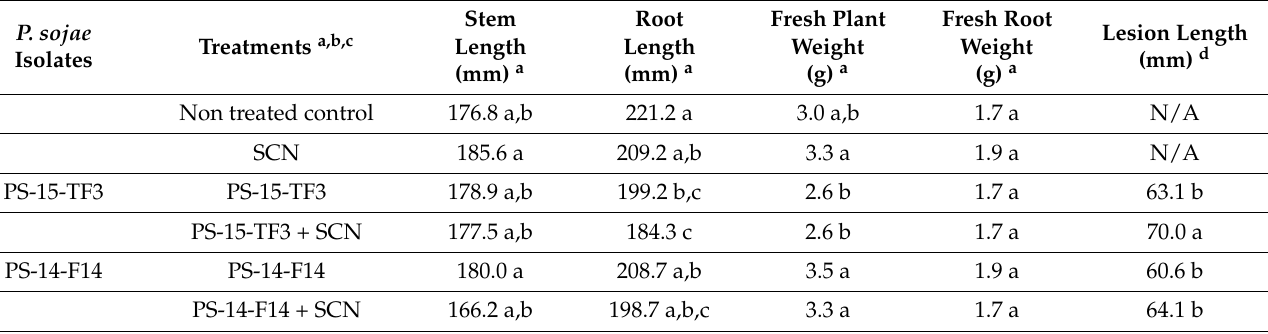
Table 4. Shoot, root length and weight, lesion length measurements observed on the soybean cv. William 82 inoculated with SCN or concomitant inoculations of SCN with either of the P. sojae isolates (PS-15-TF3 and